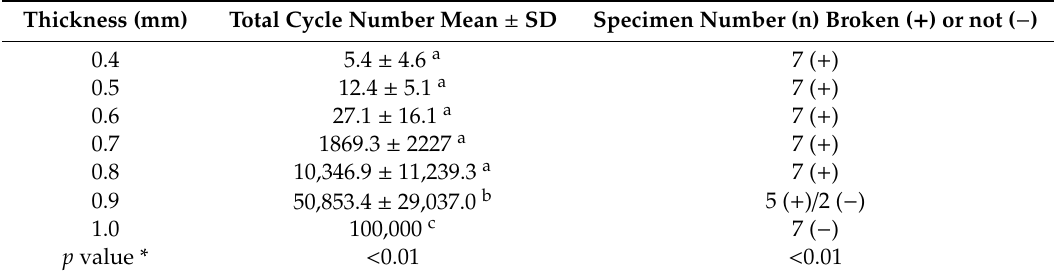
Table 1. Results of different occlusal thicknesses of zirconia specimens after cycling test under vertical 800 N loading . Thickness (mm) Total Cycle Number Mean ± SD Specimen Number (n) Broken ( + ) or not ( − )